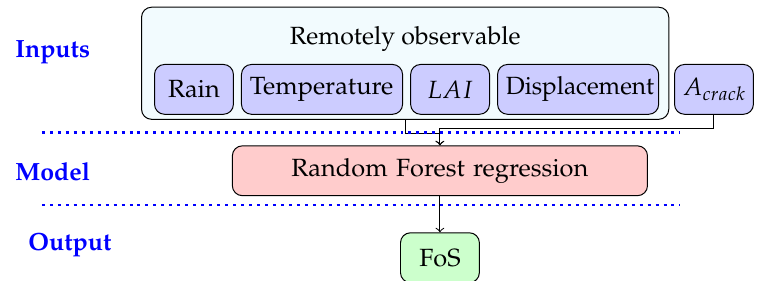
Figure 2. Flow chart of machine learning (ML) procedure.